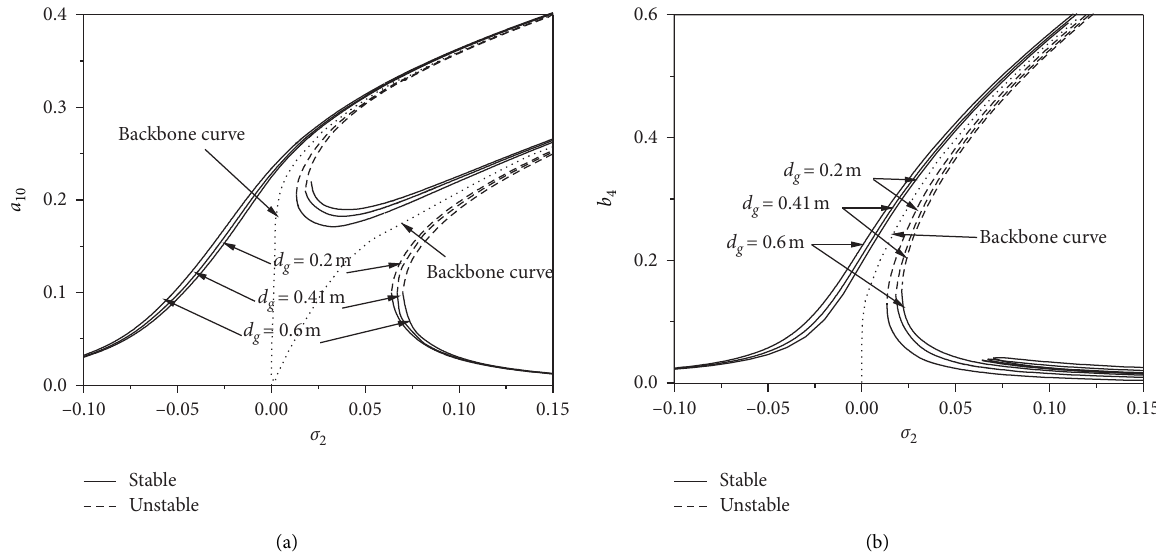
Figure 15: Effect of the arch rise d g on the frequency-response curves of the (a) cable and (b) shallow arch with Ω 4 ≈ ω 2 , 4 and ω 1 , 10 ≈ ω 2 , 4 .